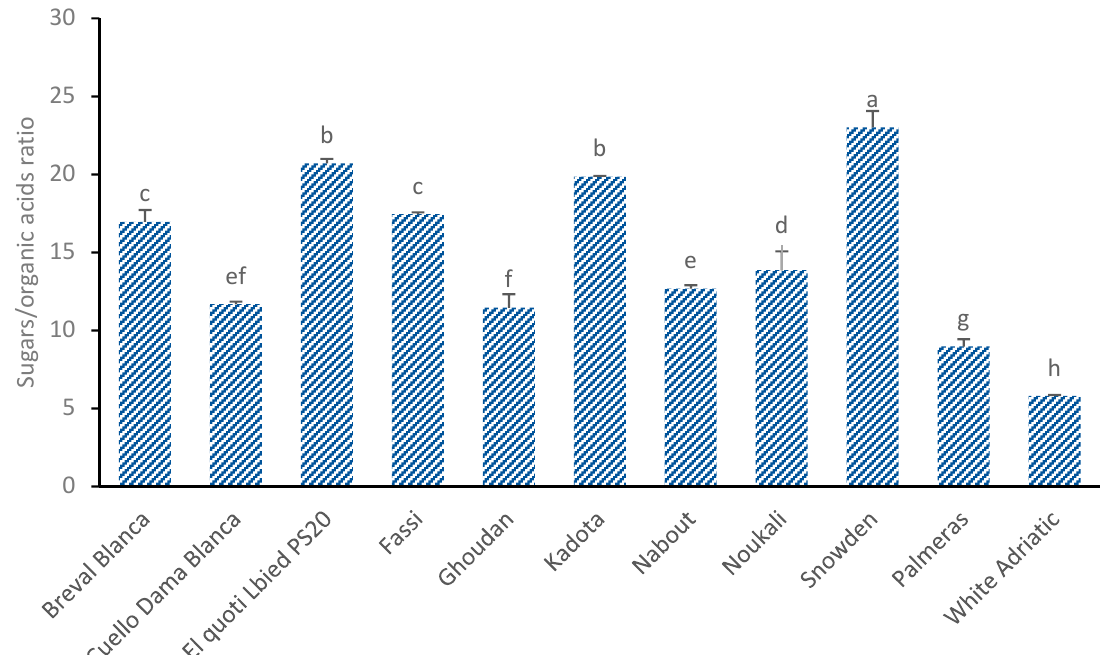
Figure 6. Sugars/organic acids ratio in the 11 studied cultivars of fig fruit. Average values ± standard deviation are presented; statistically significant differences among cultivars are displayed over error bars (a–h).